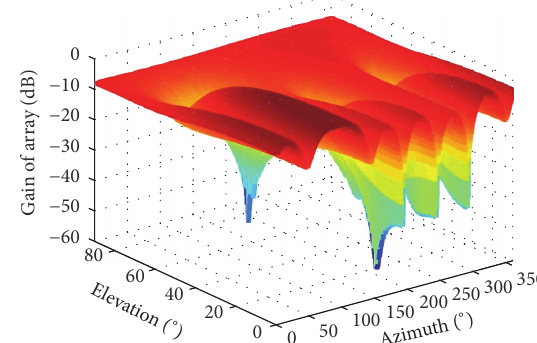
Figure 16: Beams and nulls 3D pattern of the proposed method according to the scenario in Table 2 and Jamming Scenario in Section 4.5.